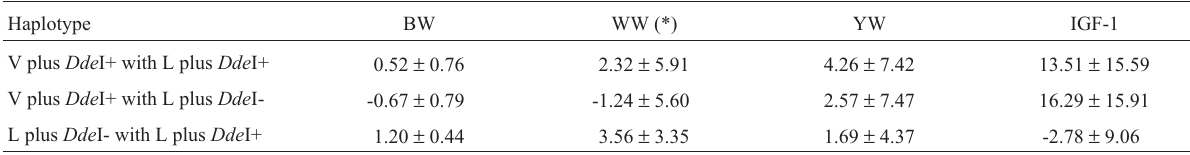
Table 6 - Average effects of haplotype substitution according to the combined distribution of the growth hormone 1 gene ( GH1 ) Alu I and Dde I polymorphisms on birth weight (BW), weaning weight (WW), yearling weight (YW) and mean plasma insulin-like growth factor-1 (IGF-1) concentra- tion of Canchim